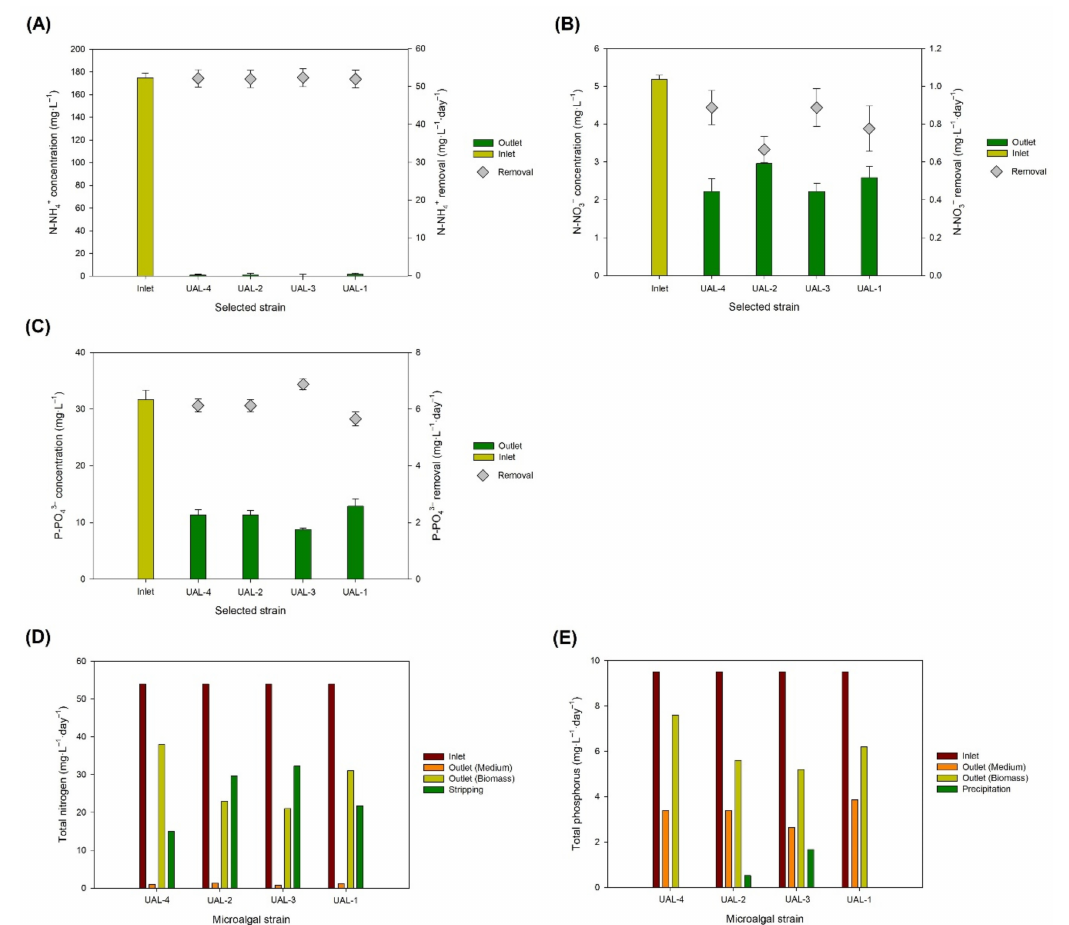
Figure 2. Concentration and daily removal of ( A ) N-NH 4+ , ( B ) N-NO 3 − , and ( C ) P-PO 43 − , along with the mass balance of ( D ) nitrogen and ( E ) phosphorus. Values represent the mean values ±